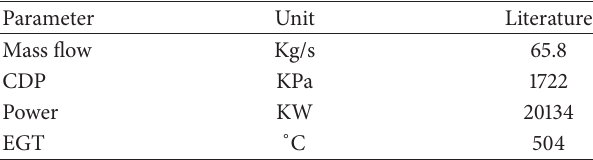
Figure 12: The pressure ratio curve with 400 hours due to fouling with different relative fouling severity coefficient. Table 5: LM2500-30 compressor operating line data (General Electric,